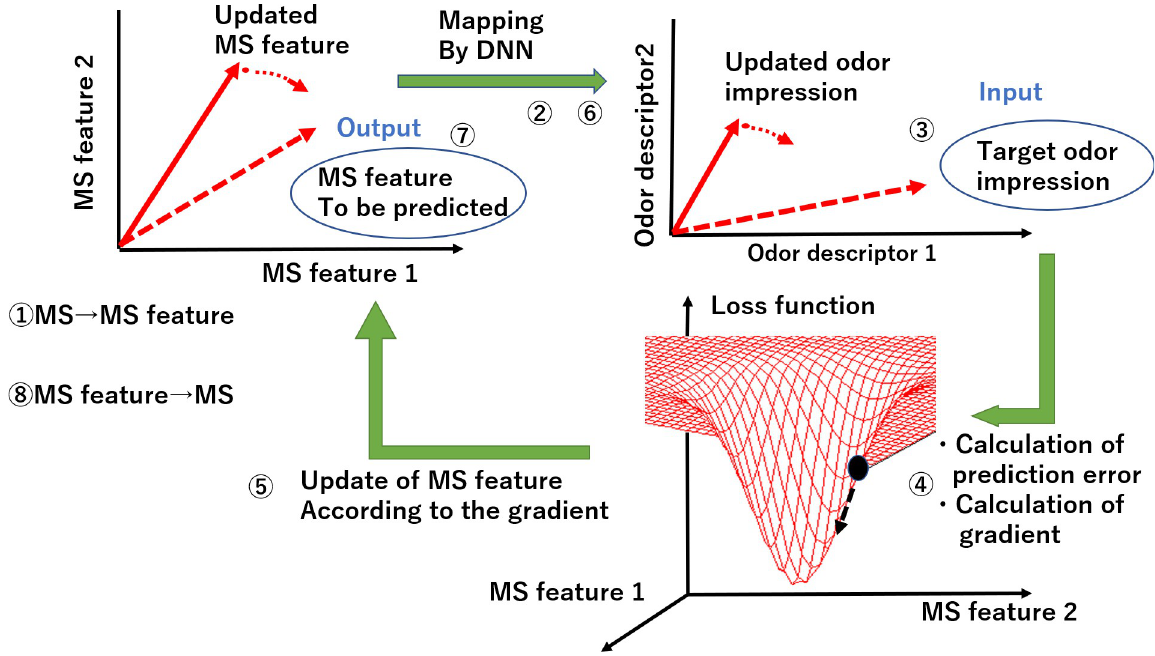
Fig 1. Principle of the prediction from odor impression to mass